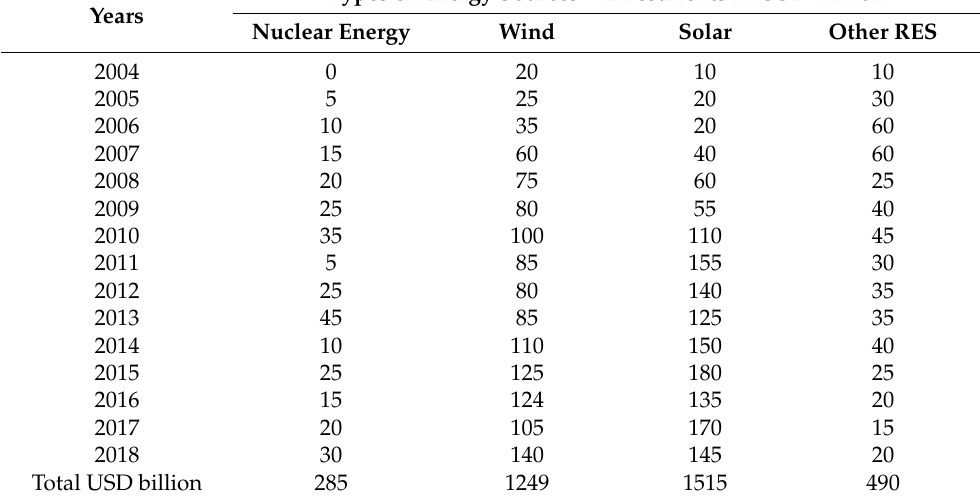
Table 4. Global investment decisions in USD billion (approximate values) regarding RES and nuclear energy in 2004–2018